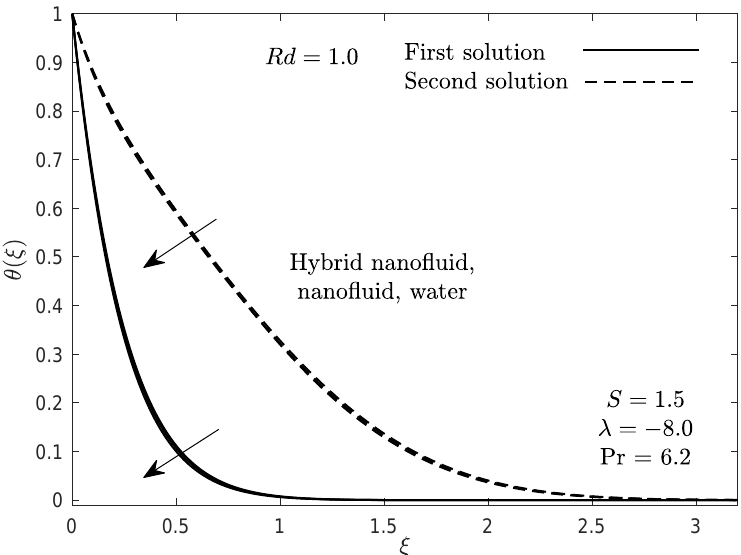
Figure 9. Impact of different fluids on temperature distributions, θ ( ξ )